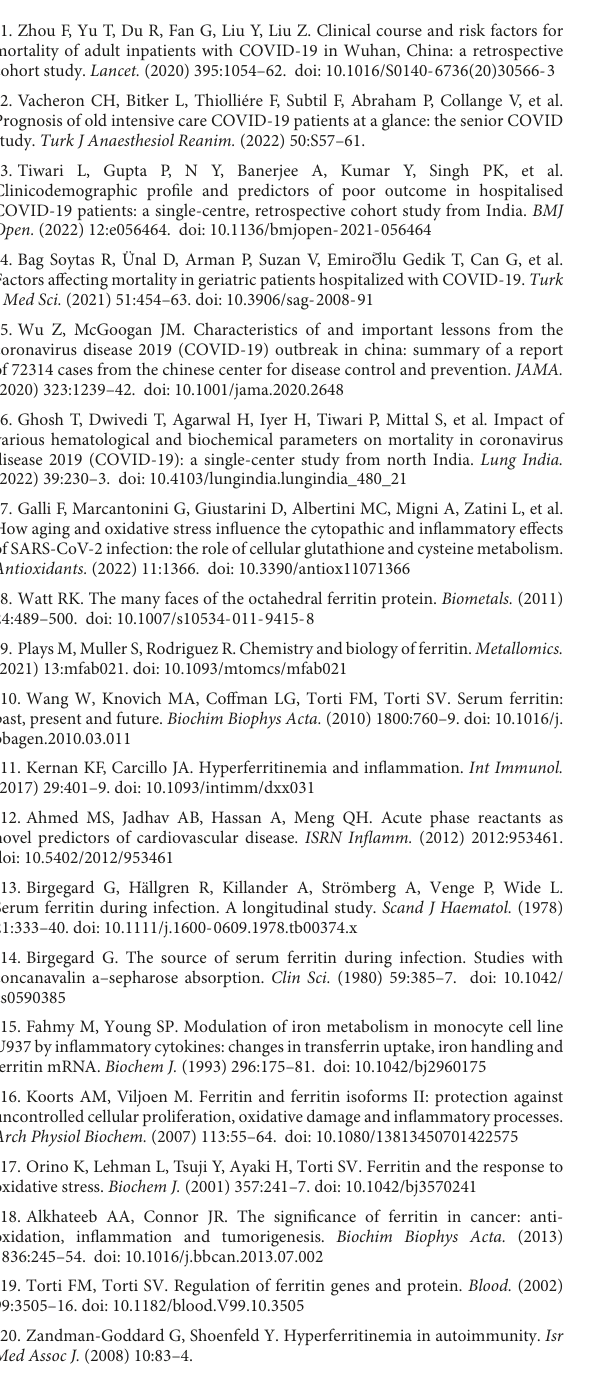
SUPPLEMENTARYFIGURE2 Percentage change from initial to peak serum ferritin concentration in COVID-19 patients with and without psychiatric comorbidity. No significant effect of psychiatric comorbidity on the percentage change in serum ferritin concentration (from initial to